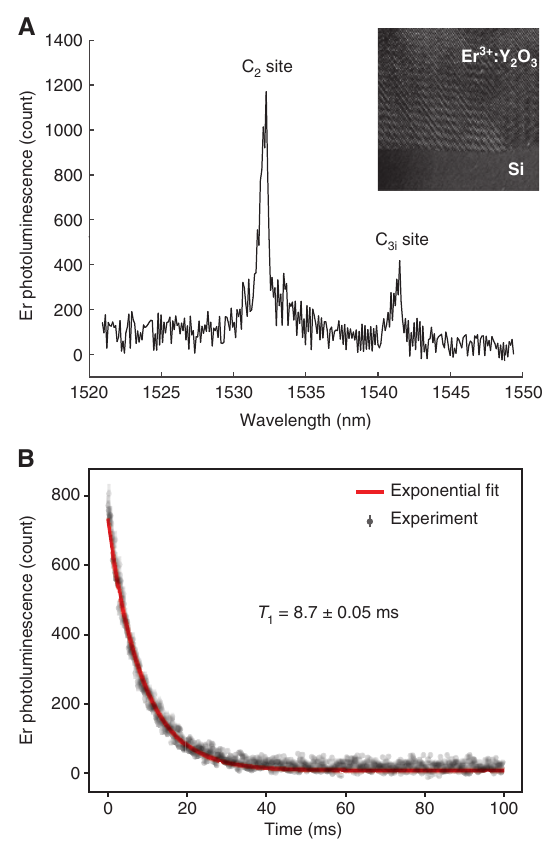
O film grown 2 3